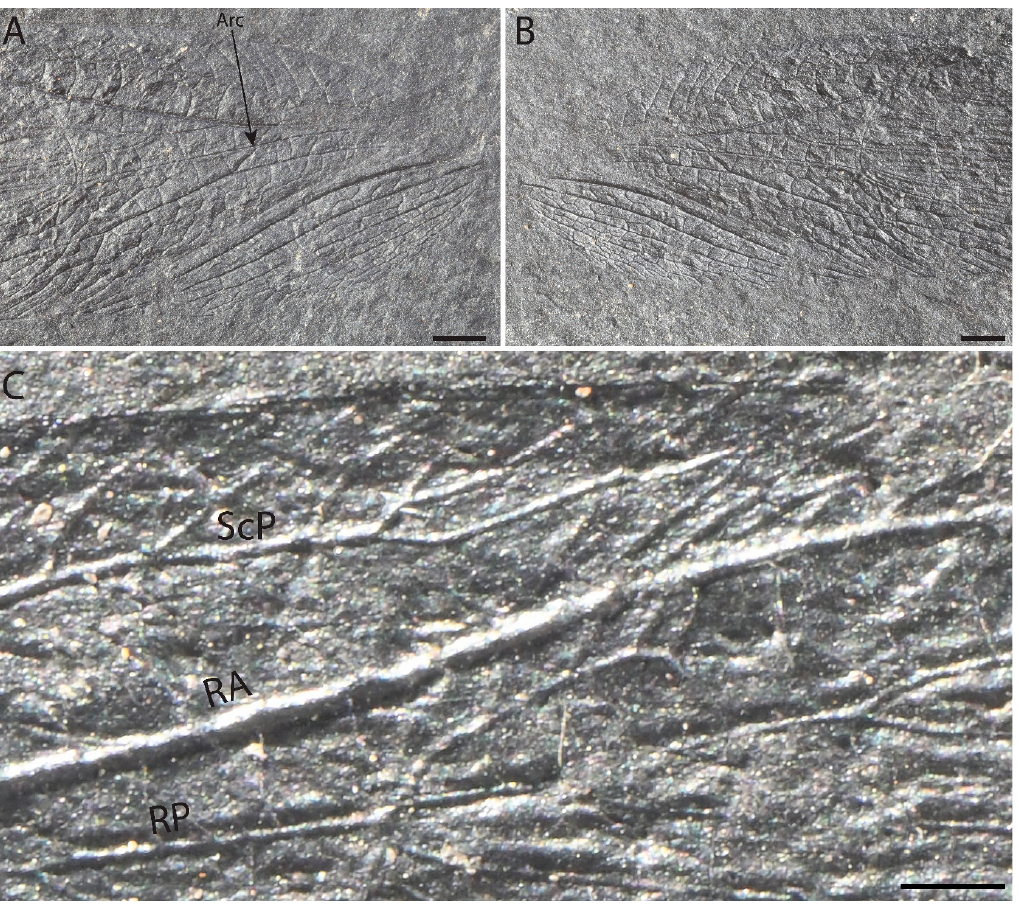
Figure 2. Glaphyrophlebia victoiriensis sp. nov., holotype MNHN.F.A71360, Gzhelian of Tante Vic- toire, France: ( A ) wing base, part; ( B ) wing base, counterpart; ( C ) region of apex of ScP with main veins labelled. Scale bars = 1 mm ( A , B ); 0.5 mm ( C